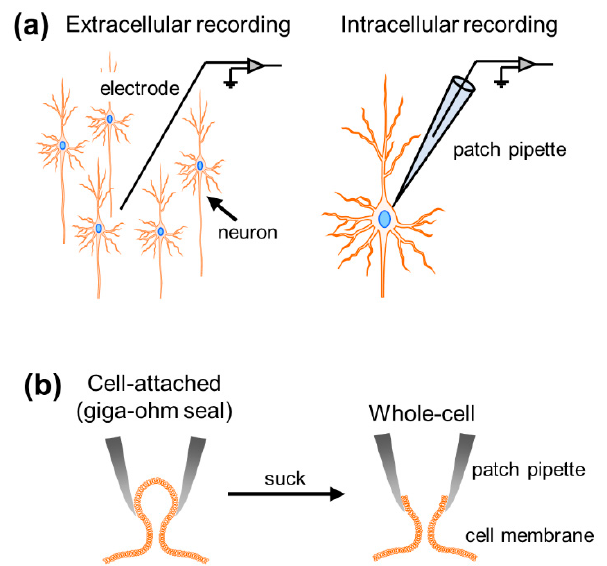
Figure 1. Overview of the patch-clamp method. ( a ) Comparison between extracellular and intra- cellular recordings. The patch-clamp method is included in the intracellular recording. ( b ) The patch-clamp method has at least two configurations. The tip of the patch pipette is tightly attached to the cell membrane, and the firing activity of a single neuron is recorded; this is called the cell-attached configuration ( left ). Then, the membrane is sucked, and the transmembrane current through the whole cell is recorded; this is called the whole-cell configuration ( right ). Some schematic drawings in Figures 1–5 are generated by modifying images available from Motifolio illustration toolkits (Motifolio Inc., Ellicott City, MD, USA).